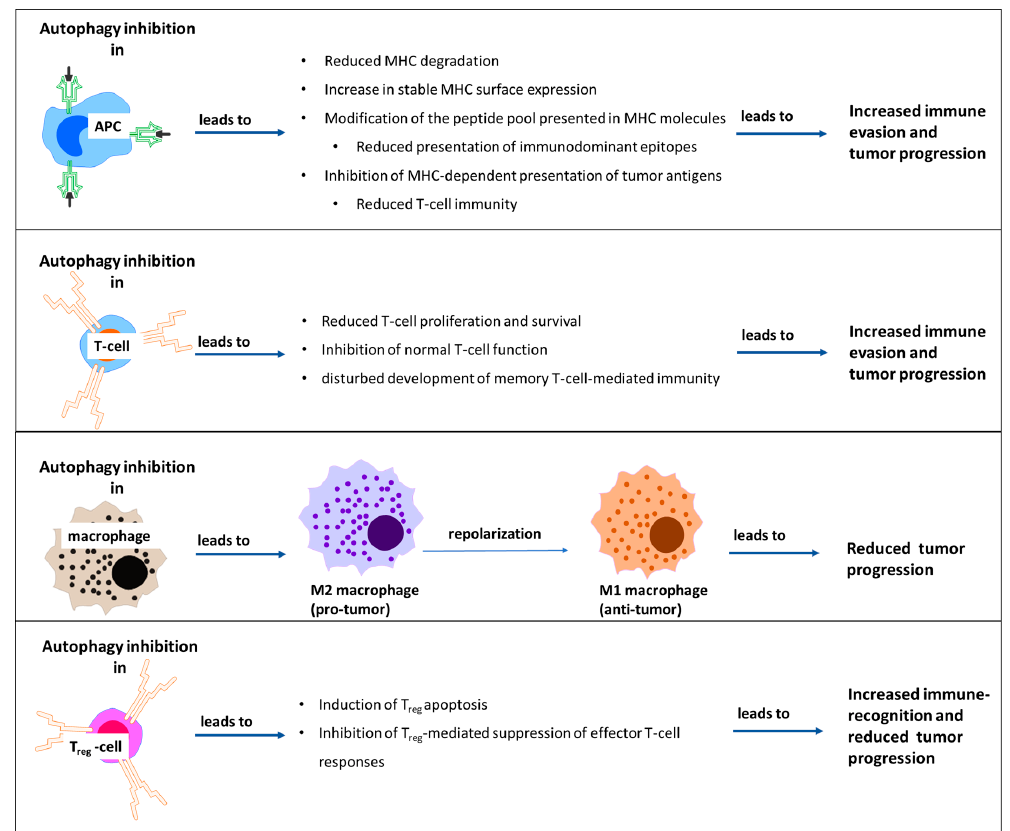
Figure 4. Effects of autophagy inhibition on cells of the immune system. APC, antigen-presenting cell; T reg , regulatory T-cell.